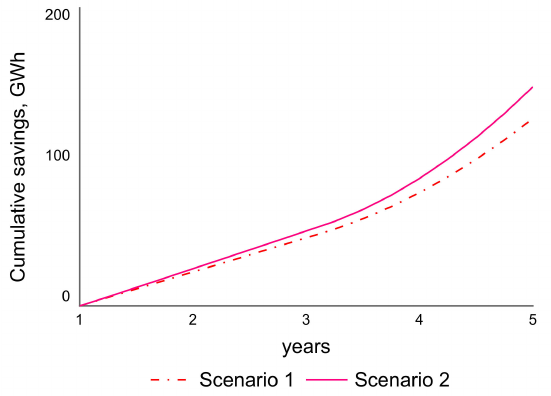
Figure 8. Cumulative savings for both scenarios.